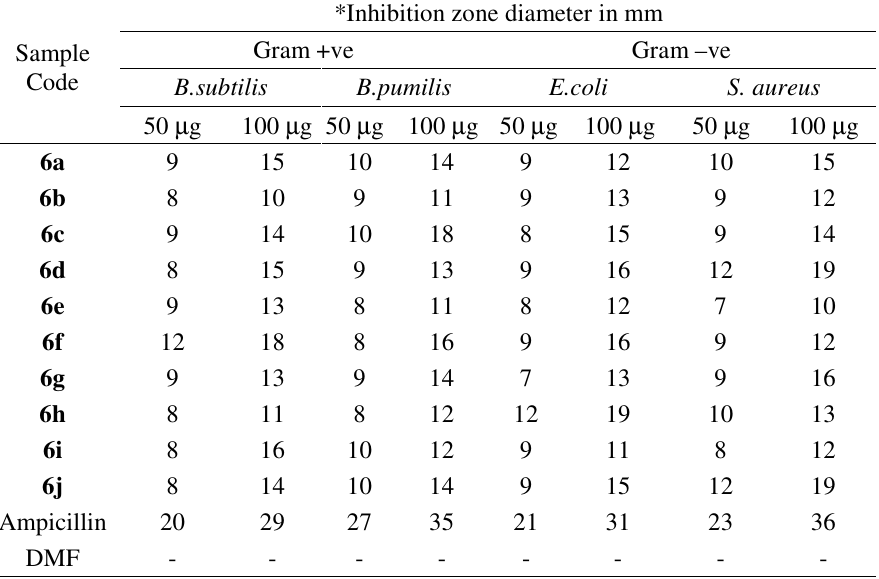
Table 2 . Antibacterial activity of synthesized